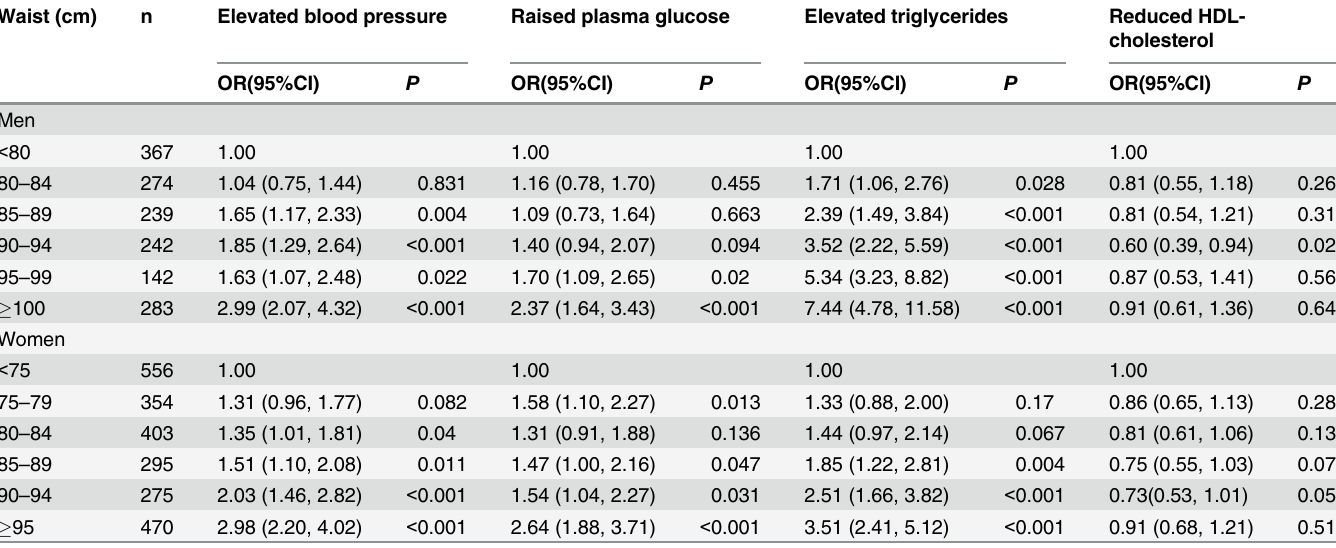
Table 4. Adjusted odds ratios of MetS components according to waist circumference category. Waist (cm)